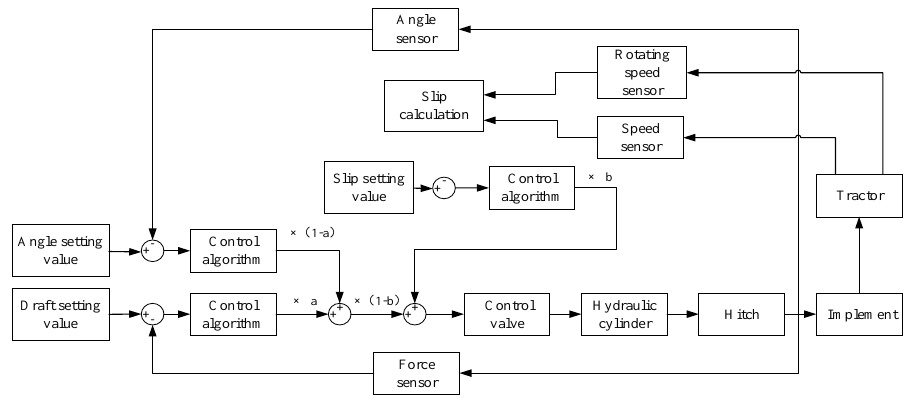
Figure 4. Three − parameter comprehensive adjustment scheme based on the weight coefficient. a. Weight of position adjustment; b. Weight of slip adjustment.